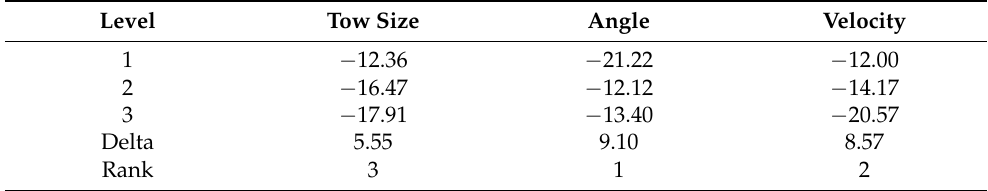
Table 7. Response table for R a.